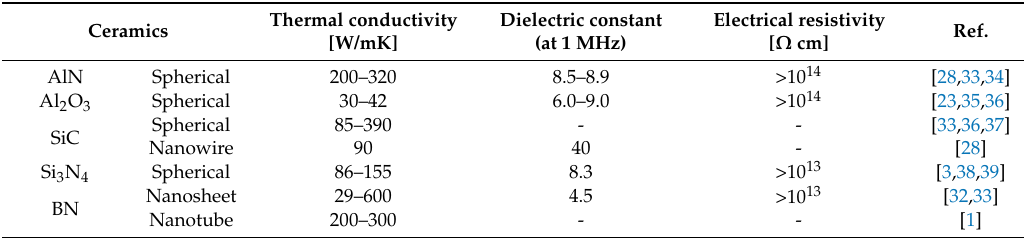
Table 1. Summary of thermal conductivity, dielectric constant, and electrical resistivity of nanoscale ceramic fillers at room